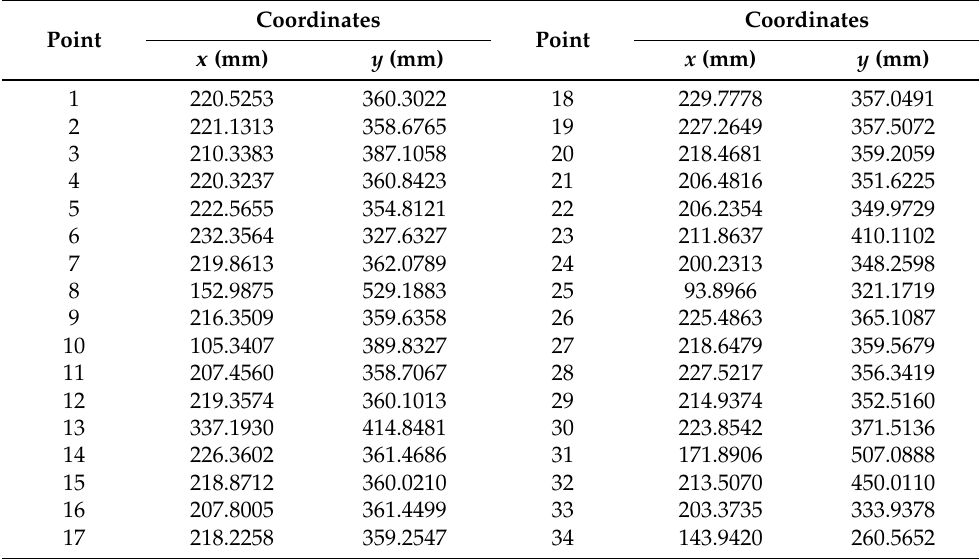
Table 9. Coordinates of the simulation intersections of two groups of 4 sensors under Case I.